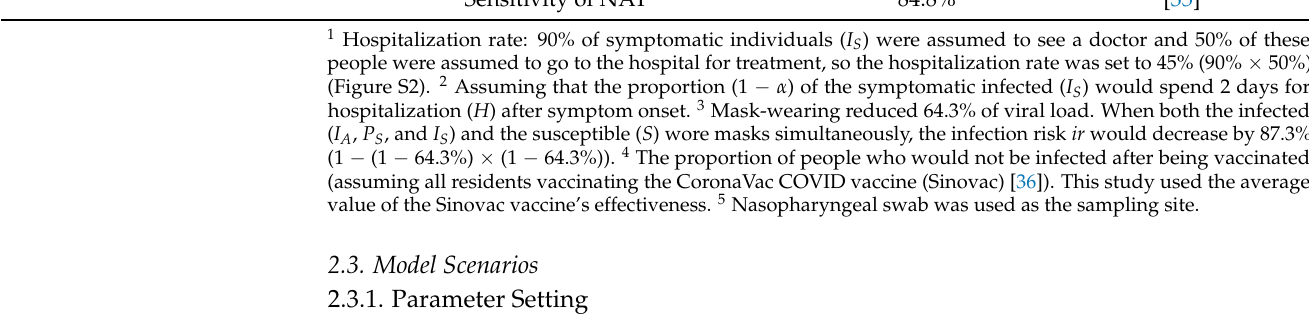
(Figure S2). 2 Assuming that the proportion (1 − α ) of the symptomatic infected ( I S ) would spend 2 days for hospitalization ( H ) after symptom onset. 3 Mask-wearing reduced 64.3% of viral load. When both the infected ( I A , P S , and I S ) and the susceptible ( S ) wore masks simultaneously, the infection risk ir would decrease by 87.3% (1 − (1 − 64.3%) × (1 − 64.3%)). 4 The proportion of people who would not be infected after being vaccinated (assuming all residents vaccinating the CoronaVac COVID vaccine (Sinovac) [36]). This study used the average value of the Sinovac vaccine’s effectiveness. 5 Nasopharyngeal swab was used as the sampling